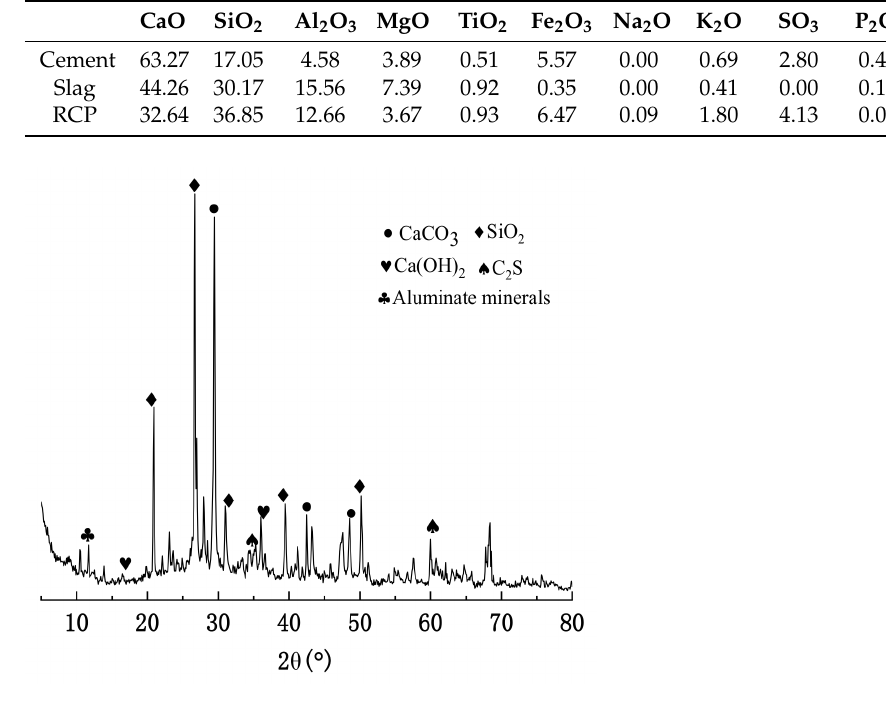
Figure 2. X-ray diffraction pattern of